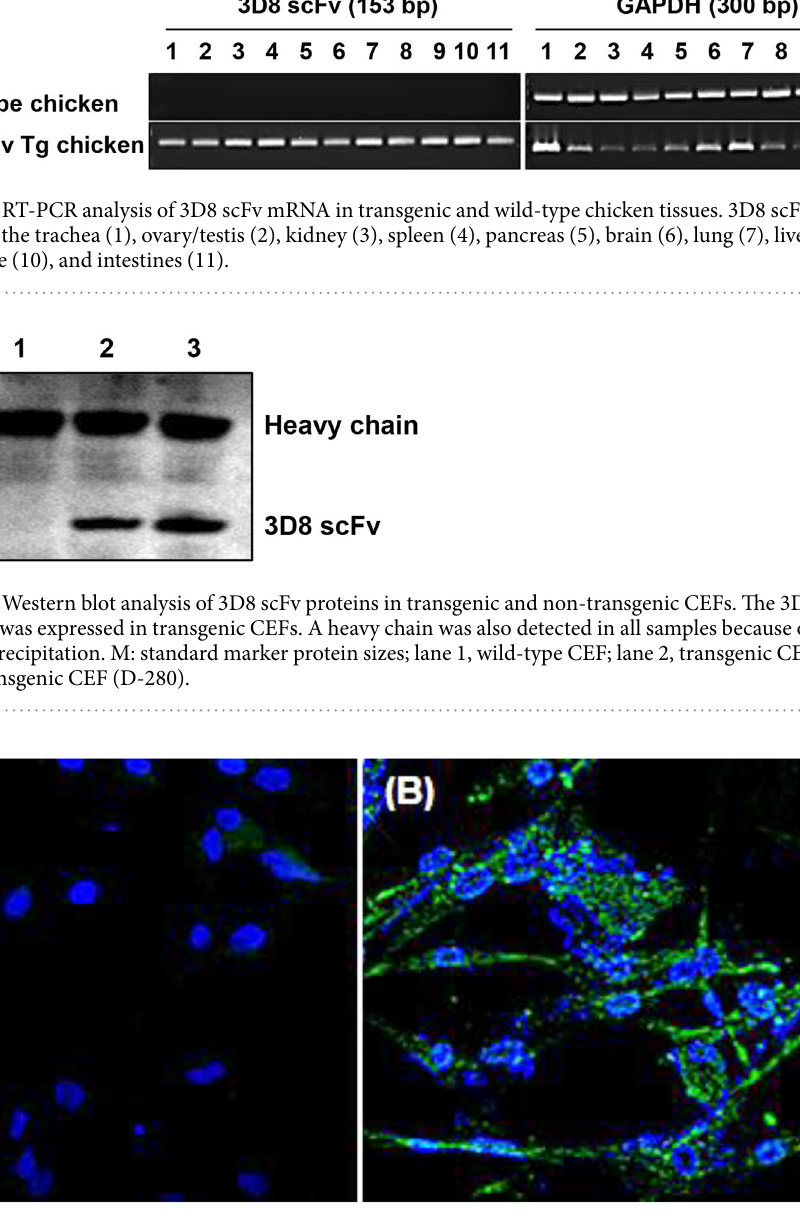
Figure 4. Cells were stained with rabbit anti-HA tag antibody and secondary FITC-anti-rabbit antibody for confocal microscopy; DAPI-stained nuclei are colored blue. Wild-type ( A ), transgenic CEFs ( B